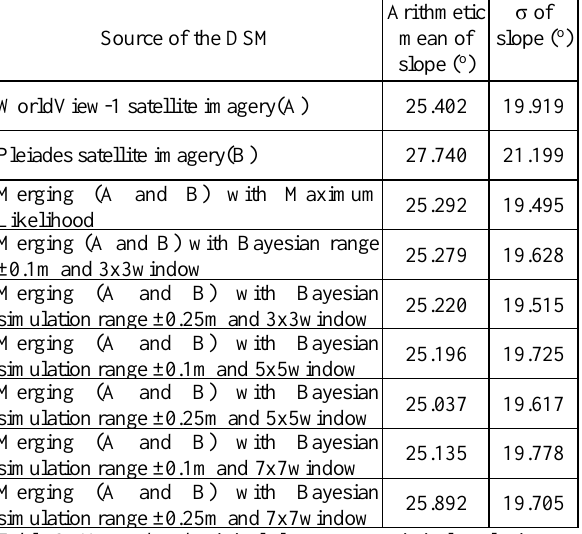
Table 2. Merged and original slope map statistical